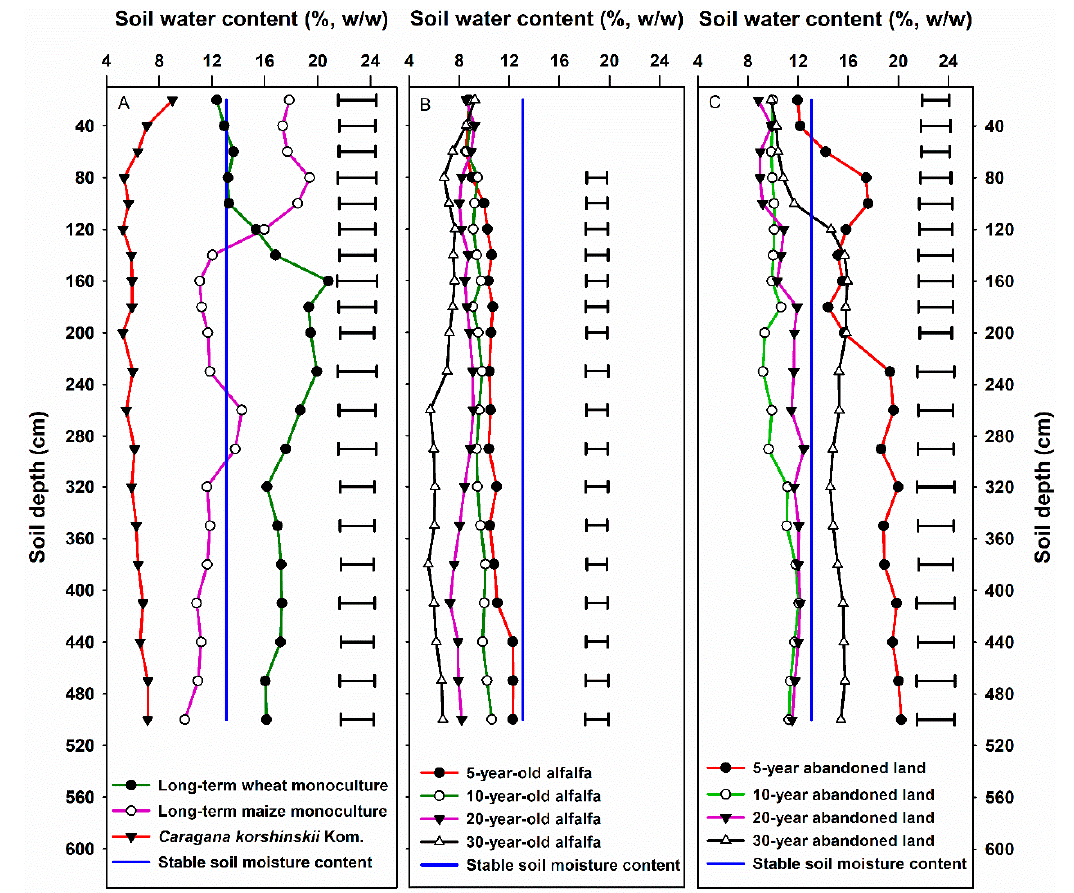
Figure 3. Effects of land use on soil water content in the 0–500 cm soil profiles under long-term wheat, maize and Caragana korshinskii Kom ( A ), alfalfa ( B ) and abandoned land ( C ). Horizontal bar denotes Fisher’s protected least significant difference at p ≤ 0.05.